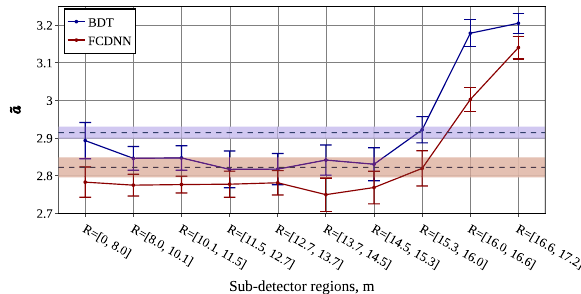
Fig. 15 Expected value of the effective resolution ˜ a for equidistant subdetectorregions.Dashedlinesandfilledareasrepresenttheeffective resolution ˜ a anditsstandarddeviationfortheBDTandFCDNNmodels, respectively. Both models are trained on data with R FV <